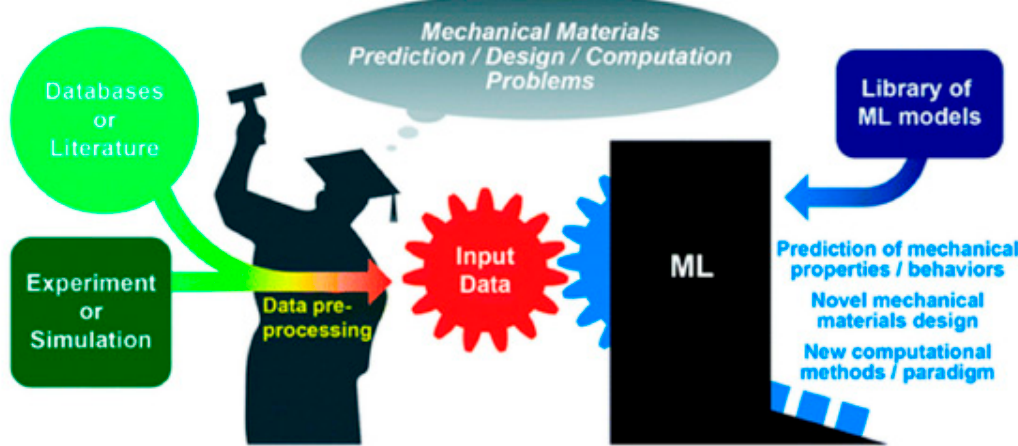
Figure 31. A typical workflow of an ML application in a material design problem